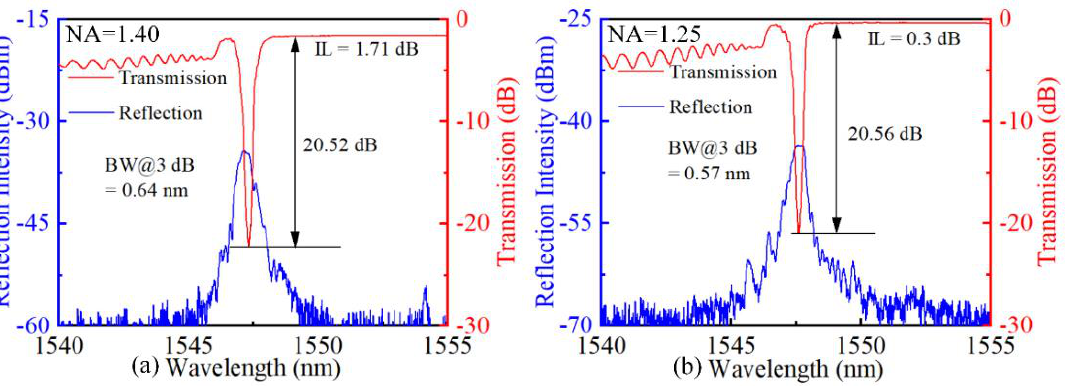
Figure 3. Transmission and reflection spectra inscribed with objective NA of ( a ) 1.40 and ( b ) 1.25.